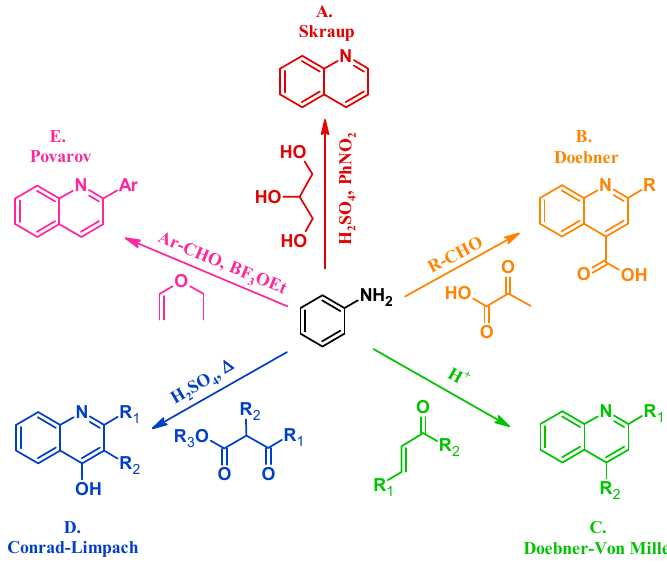
Figure 2. Quinoline synthesis methods: Skraup reaction ( A ); Doebner reaction ( B ); Doebner–Von Miller reaction ( C ); Conrad–Limpach reaction ( D ); and Povarov reaction ( E ).